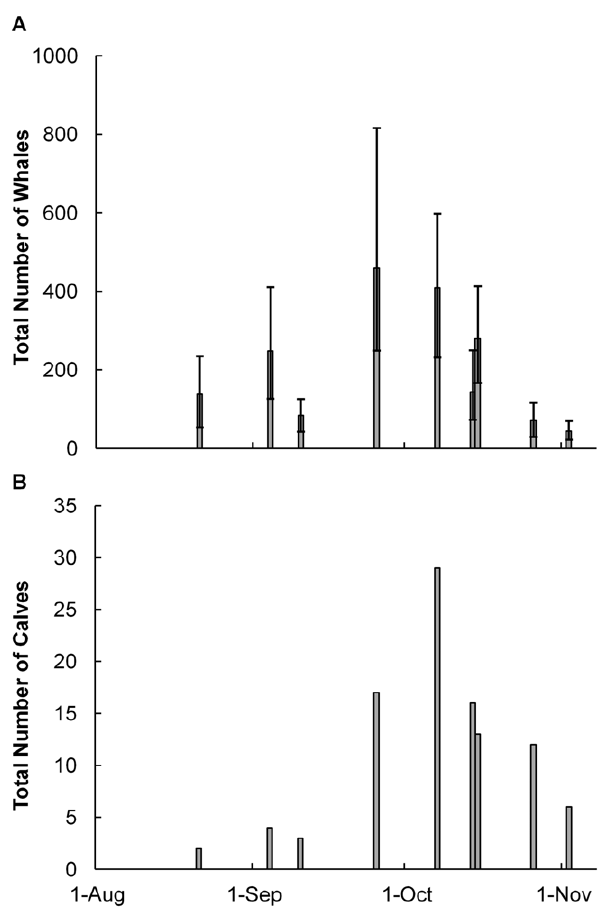
Figure 4. The temporal changes in number of A) total whales, and B) calves, in Exmouth Gulf. A) For each flight, the total number of whales resident in Exmouth Gulf was estimated using distance sampling. The error bars mark the 95% confidence interval, calculated using a bootstrap in Distance 6.0. There is clear temporal pulse of whales in the Gulf, with the peak occupancy towards the end of September. B) The total number of calves observed during each survey flight also displays a temporal pulse to occupancy, but the peak here is slightly later in the first week of October.